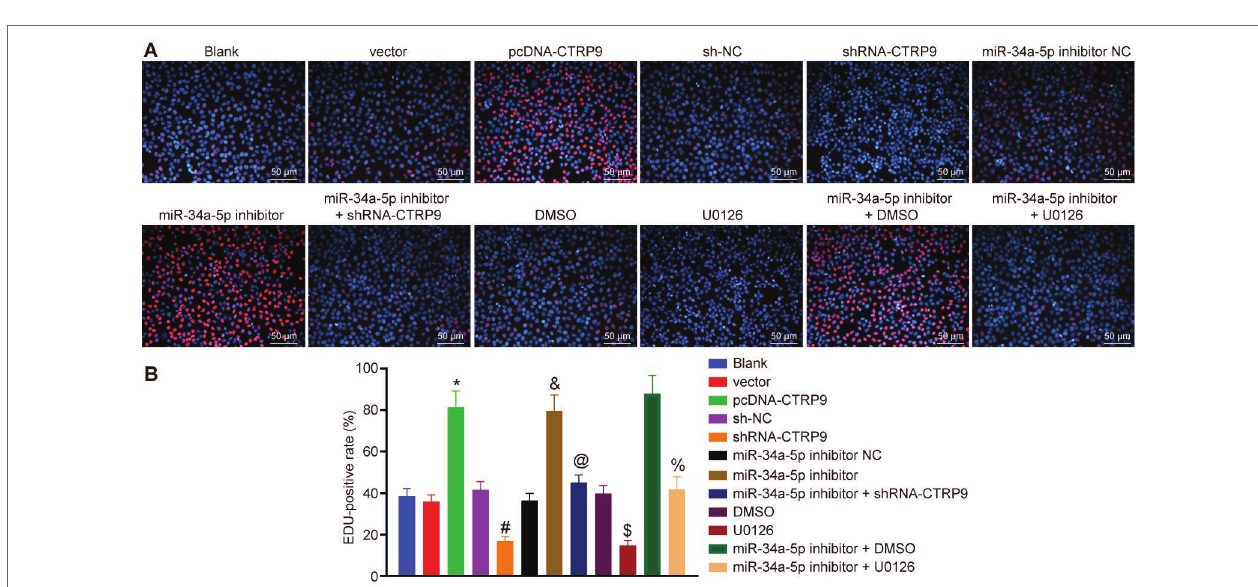
FIGURE 3 | Down-regulation of miR-34a-5p promotes ADSC proliferation by up-regulation of CTRP9 in vitro . (A,B) ADSC proliferation in each group measured by EdU assay (blue represents Hoechst-positive cells and red represents EdU-positive cells) (200 ×). * p < 0.05 vs. the vector group; # p < 0.05 vs. the sh-NC group; & p < 0.05 vs. the miR-34a-5p inhibitor NC group; @ p < 0.05 vs. the miR-34a-5p inhibitor group; $ p < 0.05 vs. the DMSO group; % p < 0.05 vs. the miR-34a-5p inhibitor + DMSO group. Data (mean ± s.d.) among multiple groups were analyzed by one-way ANOVA, followed by Tukey’s post hoc test. Log-rank was used for univariate analysis. The experiment was repeated three times. CTRP9, C1q/tumor necrosis factor-related protein-9; miR-34a-5p, microRNA-34a-5p; ADSC, adipose-derived stem cell; sh, short hairpin; NC, negative control; EdU, 5-ethynyl-2 ′ -deoxyuridine; DMSO, dimethyl sulfoxide; s.d., standard deviation; ANOVA, analysis of